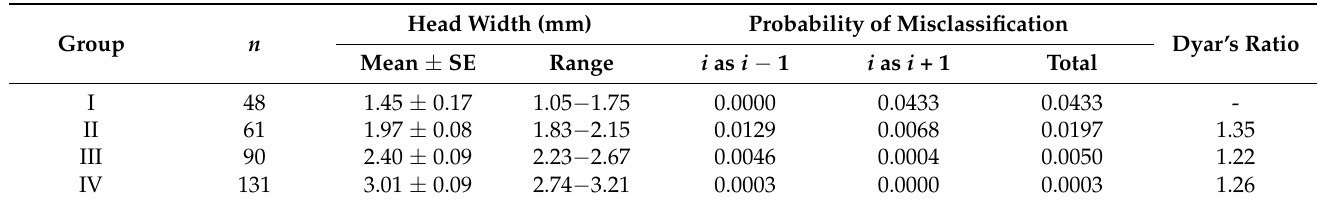
Table 1. Mean head widths, ranges, and misclassification probabilities of the four larval groups of Nannophya koreana calculated using the Hcap program and Dyar’s ratio.